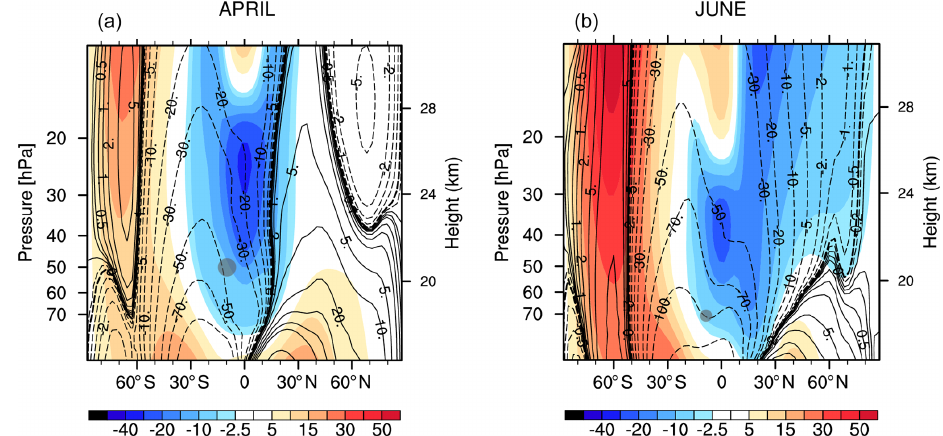
Figure 2. Monthly mean zonal wind (ms − 1 ) of AGUNG2 for April (a) and June (b) 1963 in shading. Contour lines show the stream function (kgs − 1 ). Positive (solid) streamlines describe clockwise circulation, negative (dashed) ones counterclockwise circulation. The gray dots mark the injection location of the two volcanic